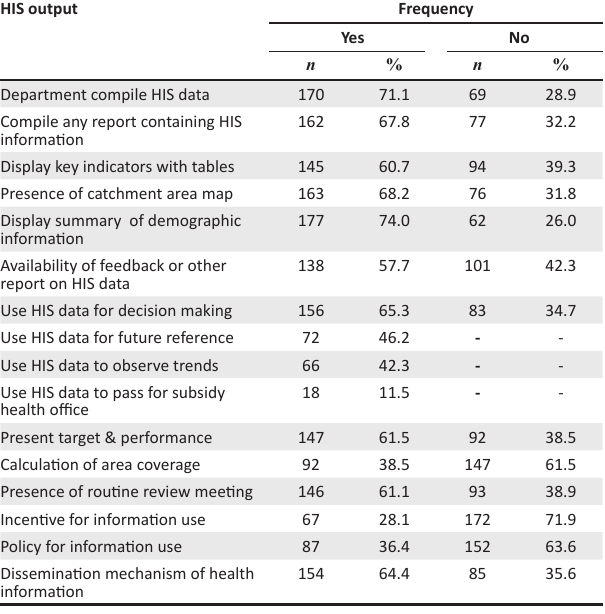
TABLE 4: Health facility department’s HIS output in Dire Dawa Administration, April 2013.